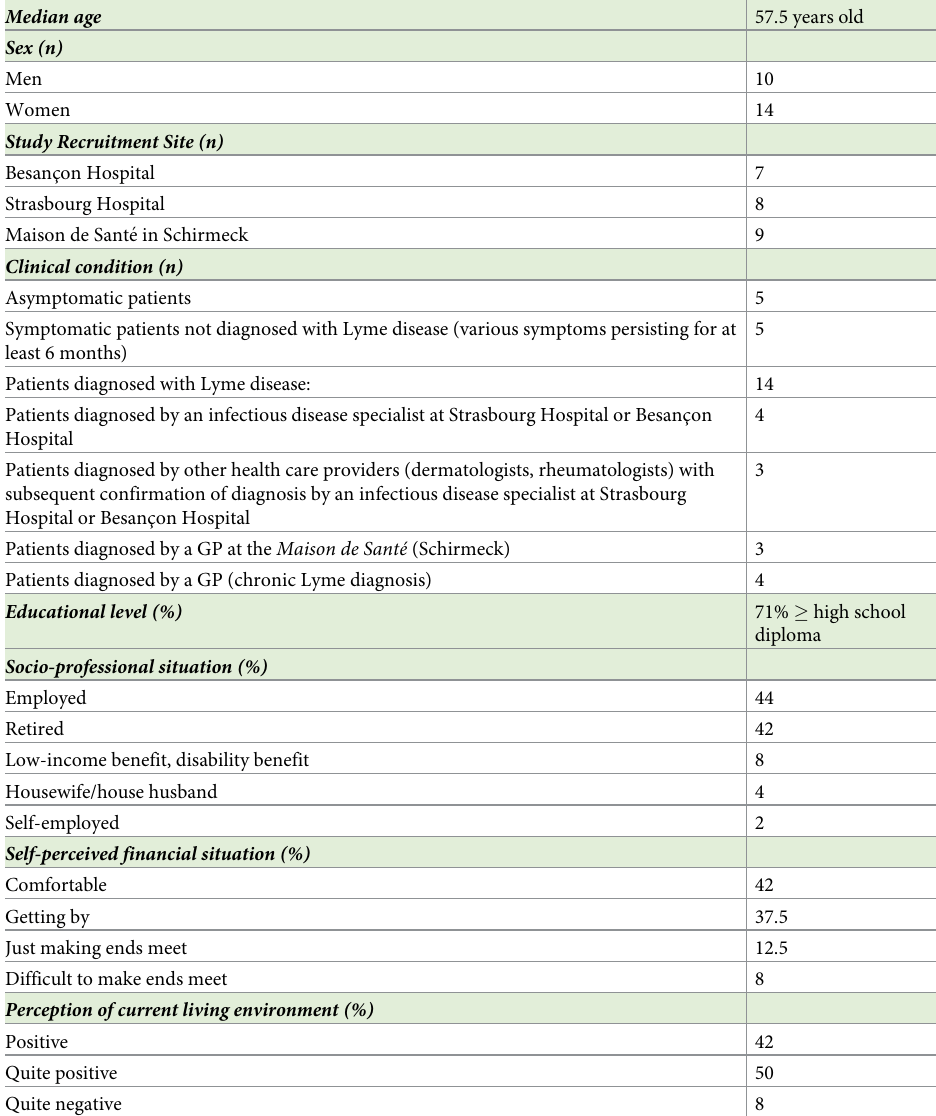
Table 1. Characteristics of the study population (n =